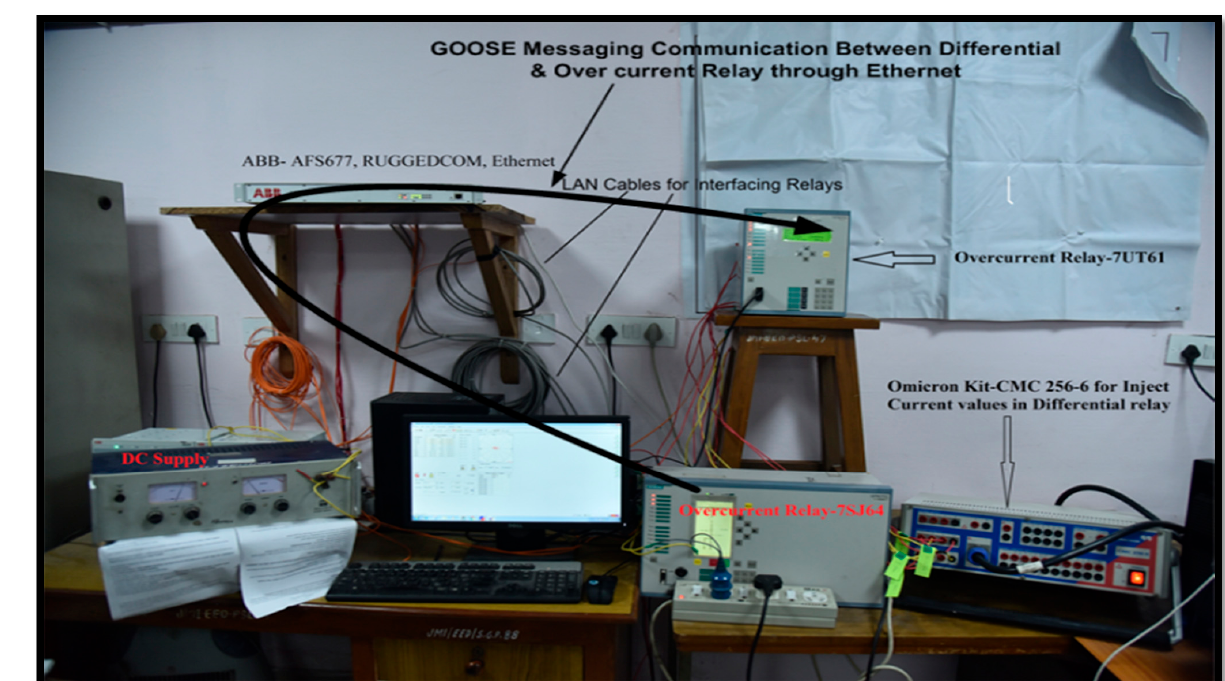
Figure 5. Hardware set-ups with current differential function for power transformer Harmonic Blocking.